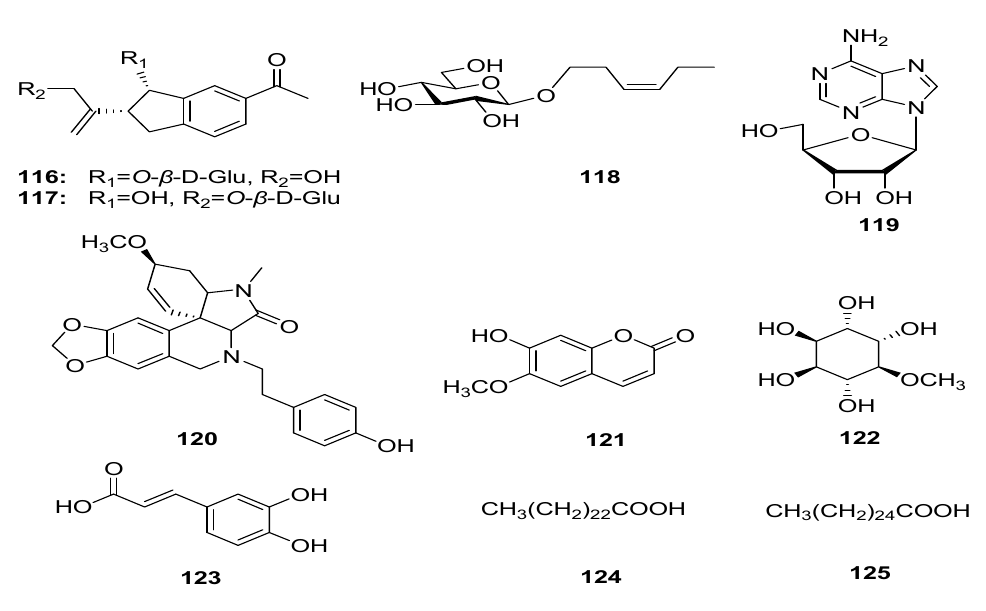
Figure 7. Chemical structures of other compounds isolated from the genus Gnaphalium